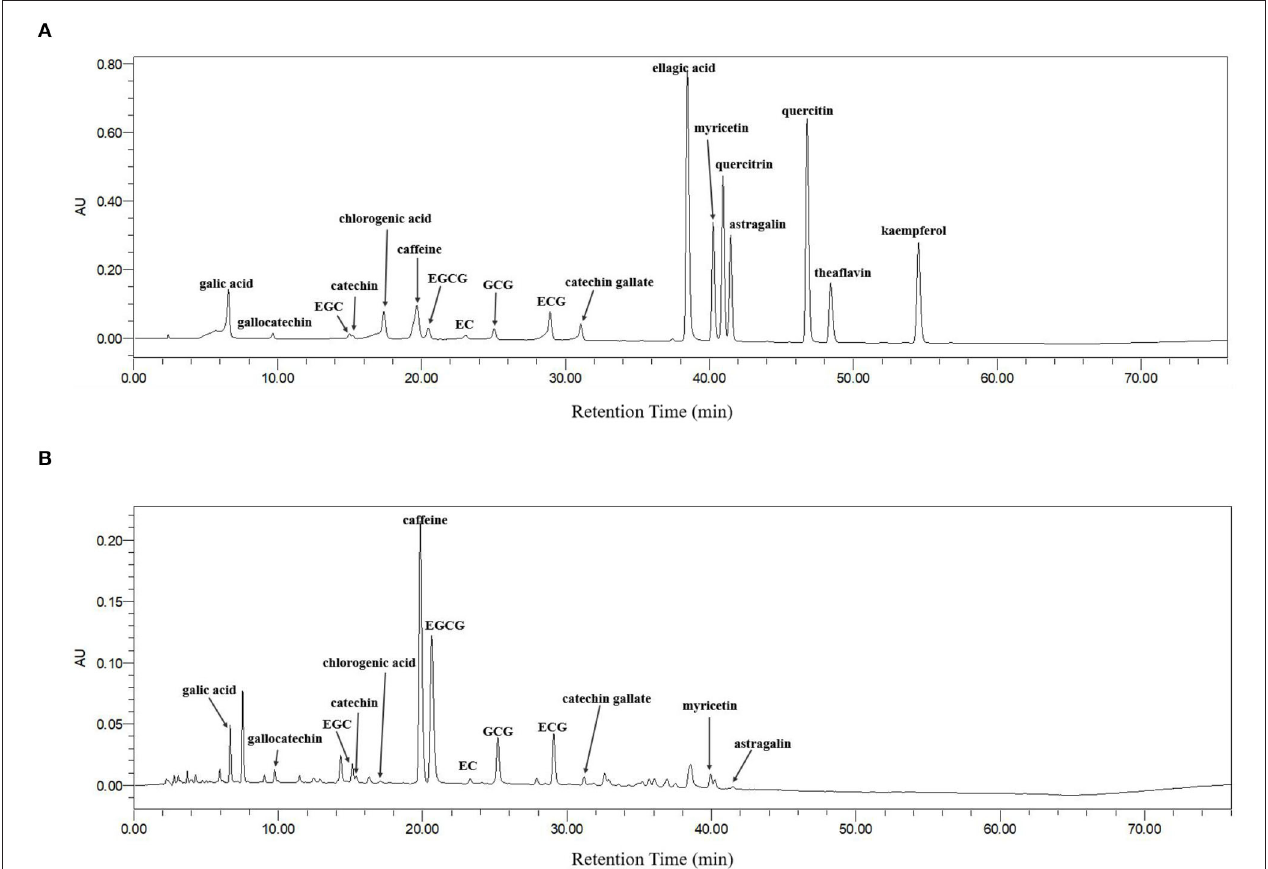
FIGURE 9 | The high-performance liquid chromatography (HPLC) chromatograms of the standard components (A) and Liping Xiang Tea (B) at 254nm.